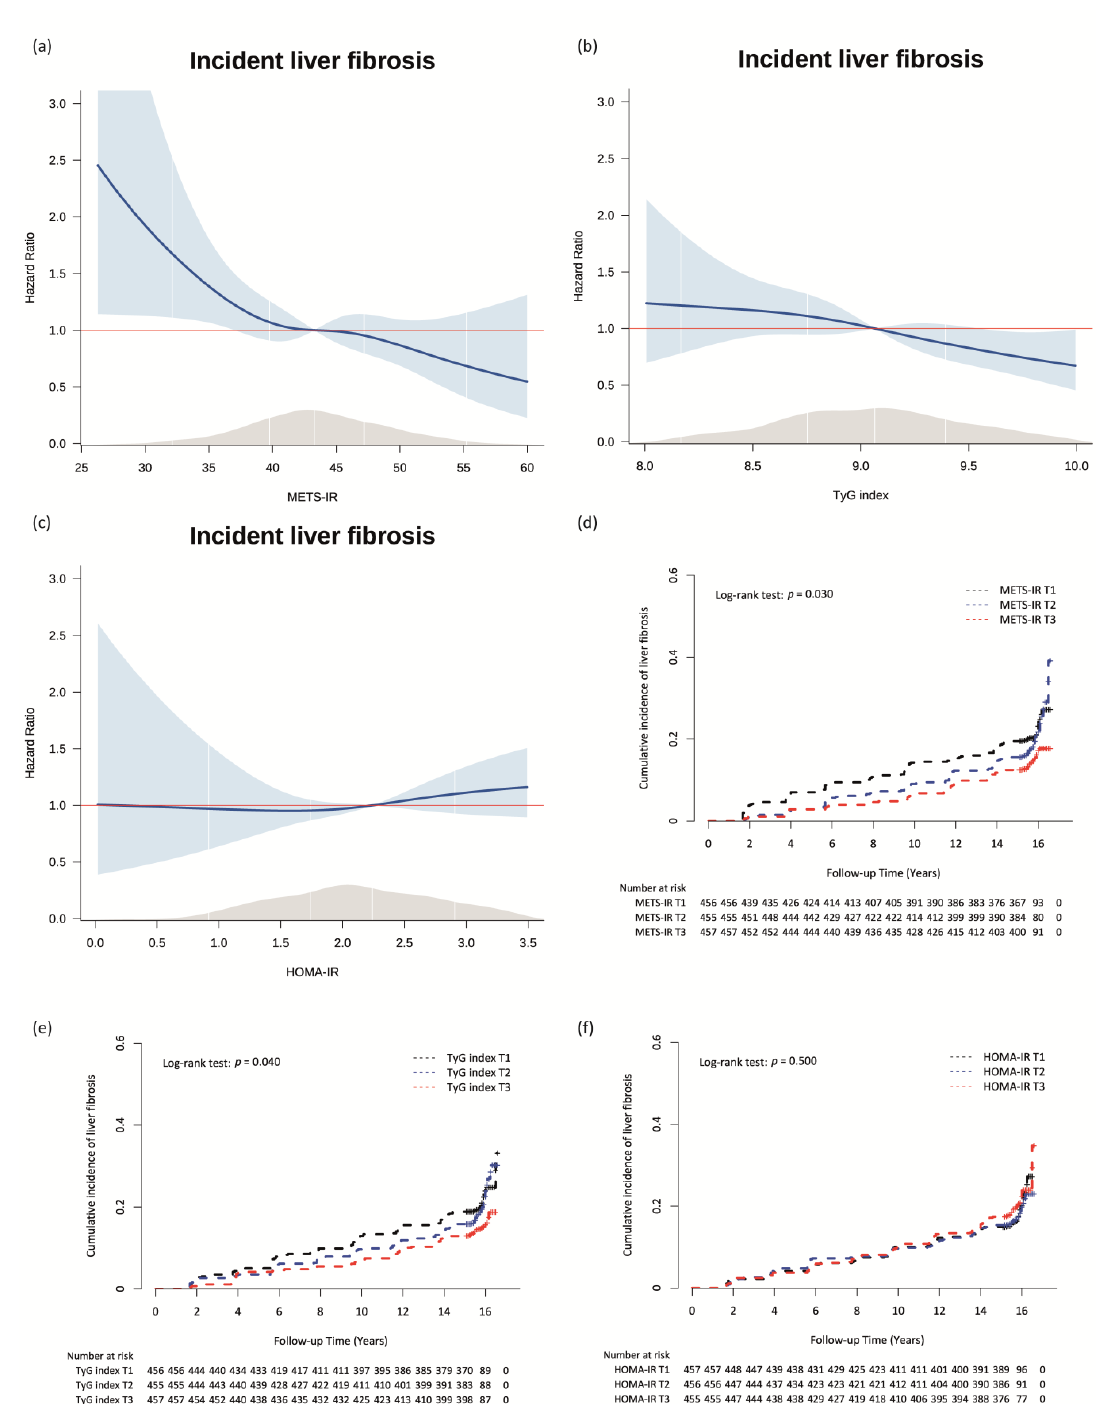
Figure 2. Relationships between the METS-IR, TyG index, and HOMA-IR and incident ALF. Cox proportional hazards spline curve showing the dose-response relationships between incident ALF and ( a ) METS-IR, ( b ) the TyG index, and ( c ) HOMA-IR. The red line indicates a hazard ratio of 1. The blue lines represent the hazard ratio for incident ALF of METS-IR, TyG index, and HOMA-IR. The blue area represents 95% confidence interval for hazard ratio. The grey area represents density of values. Kaplan-Meier curves showing the cumulative incidence rate of ALF according to the tertiles of ( d ) the METS-IR, ( e ) TyG index, and ( f ) HOMA-IR. Abbreviations: METS-IR, metabolic score for insulin resistance; TyG, triglyceride-glucose; HOMA-IR, homeostatic model assessment for insulin resistance; ALF, advanced liver